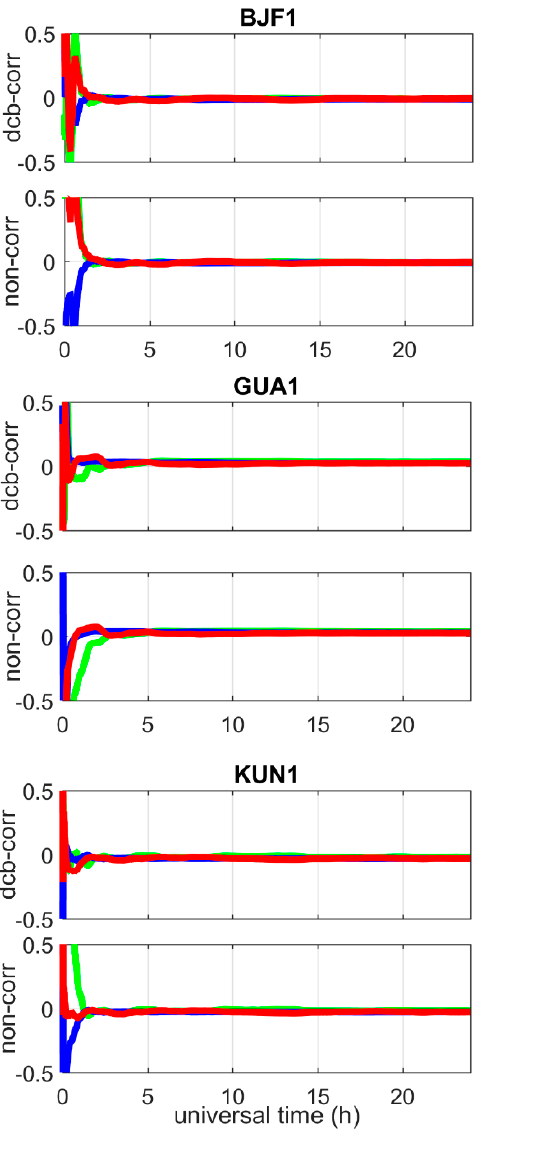
Figure 22. Positioning error of B1C/B2a PPP with and without DCB correction at six stations (unit: m). Table 6. RMS of BDS-3 PPP with and without DCB correction (m).